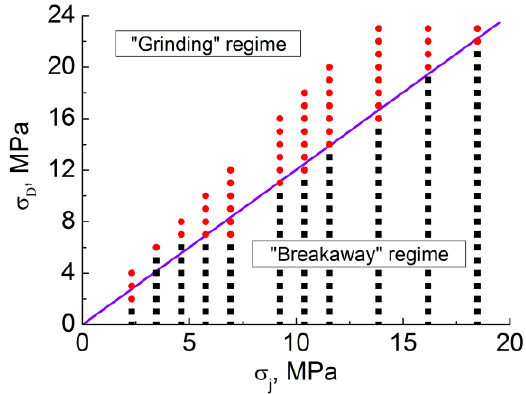
Fig. 5. The “cloud” of points in the coordinate plane ( σ j , σ D ), where σ j is the shear strength of the material,  D is the adhesion stress. The straight line approximates the profile of the border between the regions of “grinding” and “breakaway” regimes of